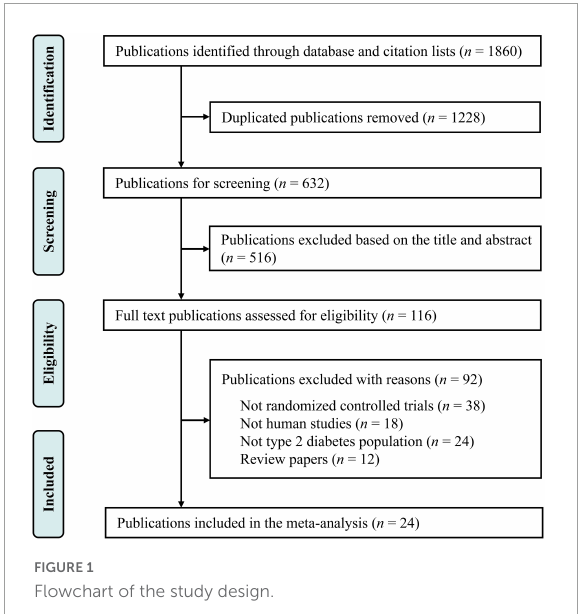
FIGURE1 Flowchart of the study